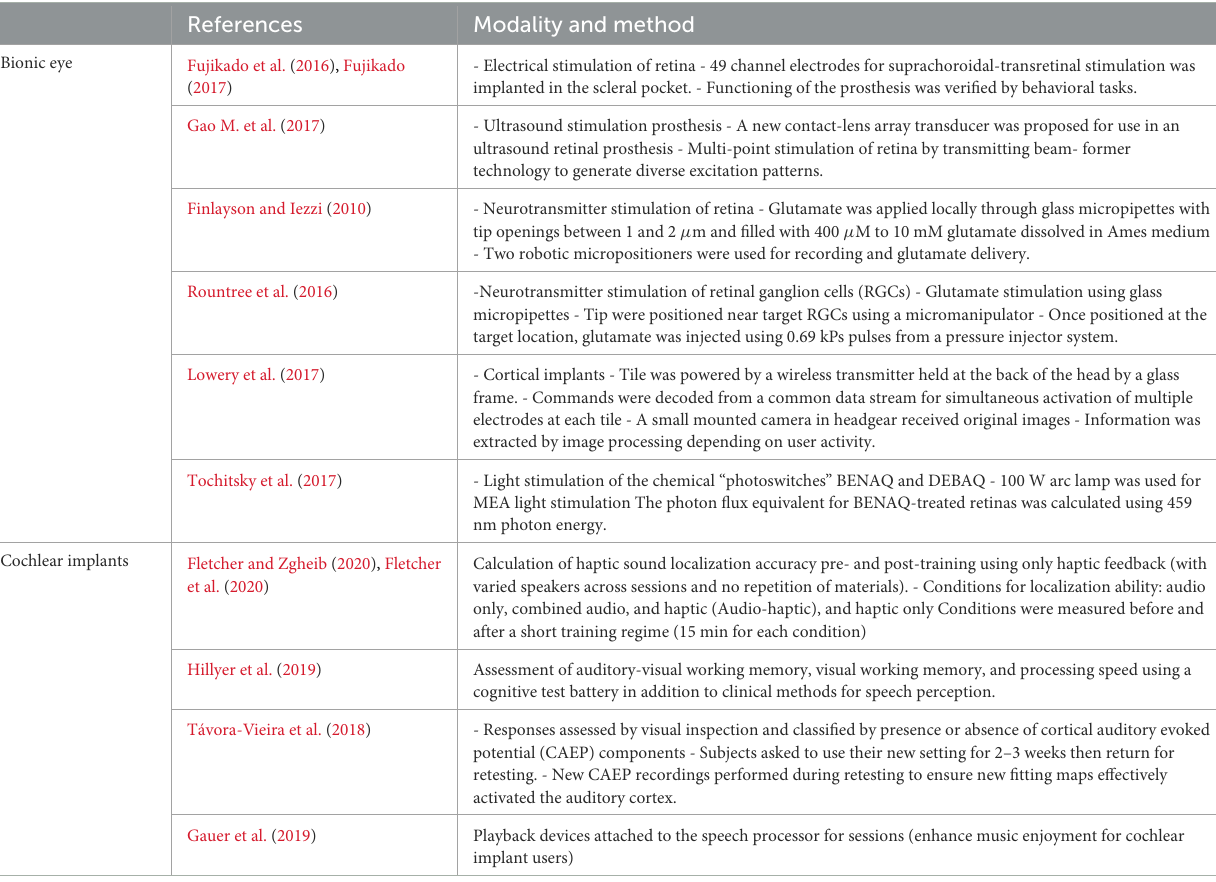
TABLE 4 Selected of the potential studies and their technique for bionic eye and cochlear